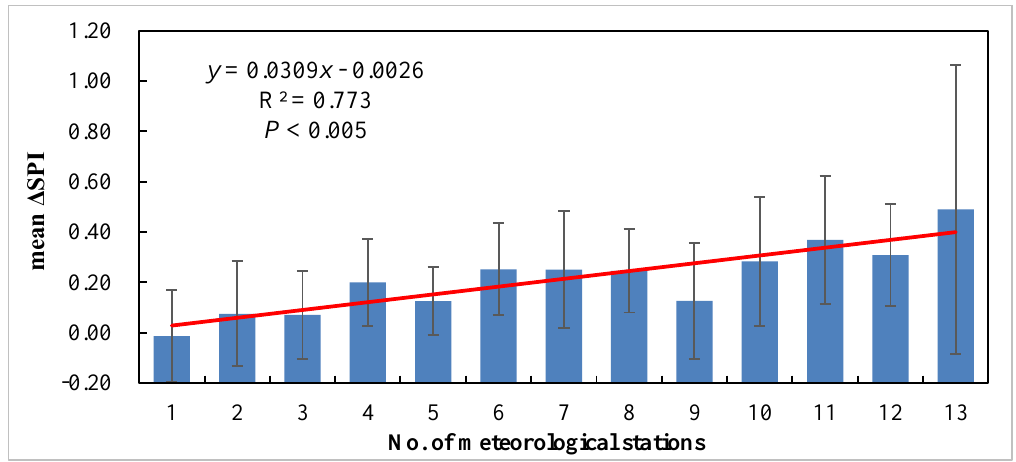
Figure 6. The relationship between ΔSPI (= SPI A − SPI B ) and the number of meteorological stations for monitoring regional droughts in the same period, along with a regression line for the relationship.